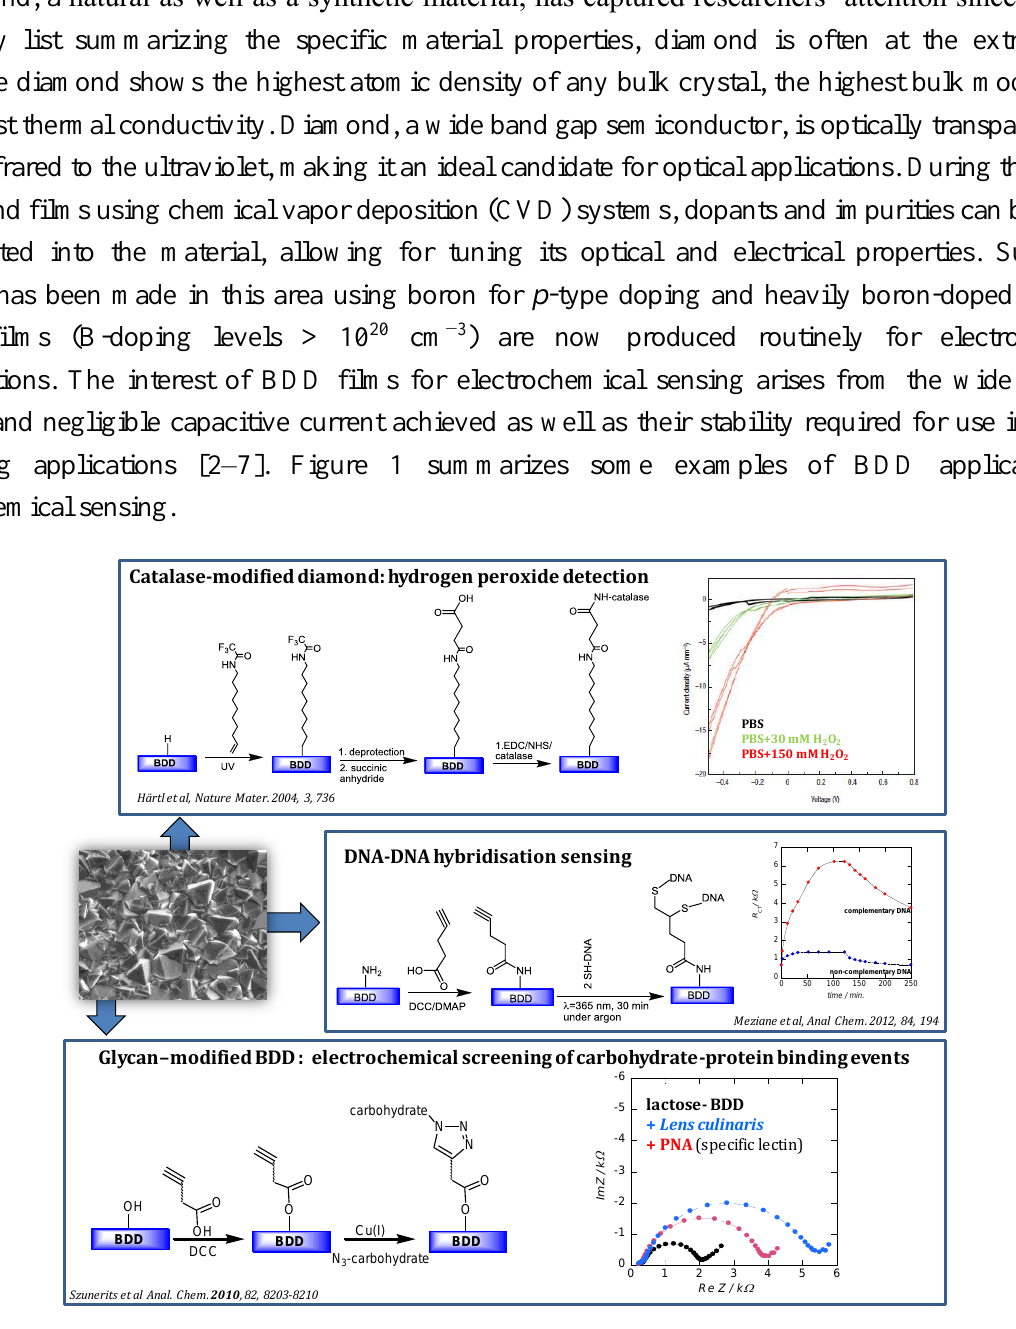
Figure 1. Selected examples of electrochemical sensing using BDD